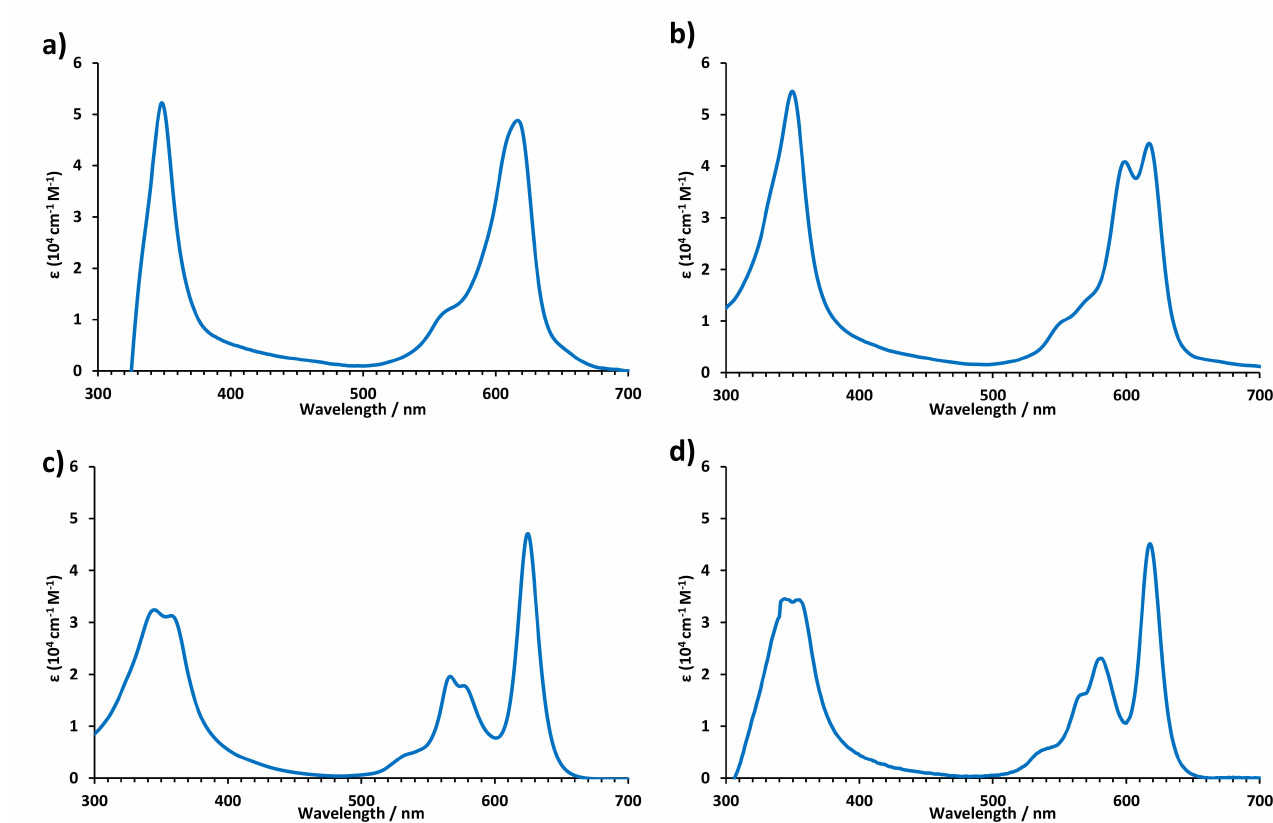
Figure 3. UV-Visible absorption spectra of Pzs ( a ) 5 , ( b ) 8 , ( c ) 9 and ( d ) 10 in